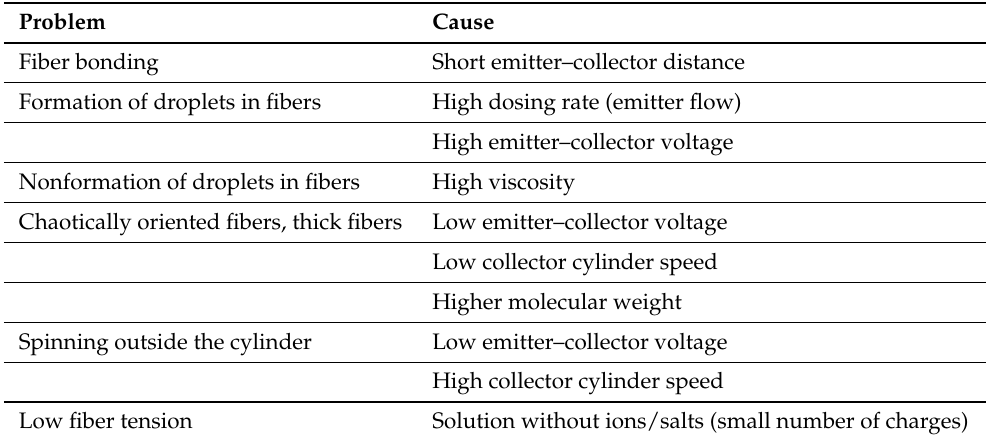
Table 2. The most common electrospinning problems in which PVDF nanofiber imperfections occur